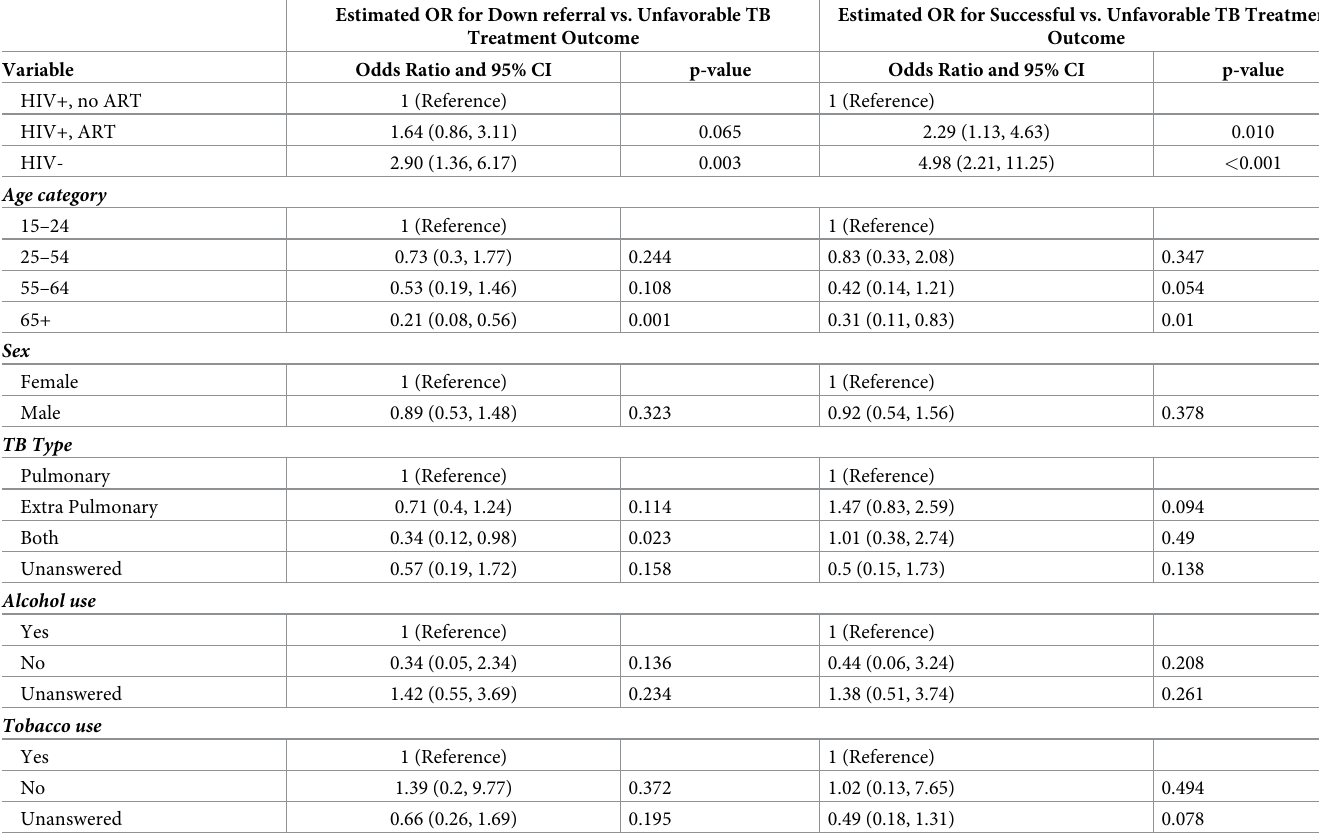
Table 3. Estimated odds ratios for Down referral vs. Unfavorable and Successful vs. Unfavorable TB treatment outcome (N = 711). Estimated OR for Down referral vs. Unfavorable TB Estimated OR for Successful vs. Unfavorable TB Treatment Treatment Outcome Outcome